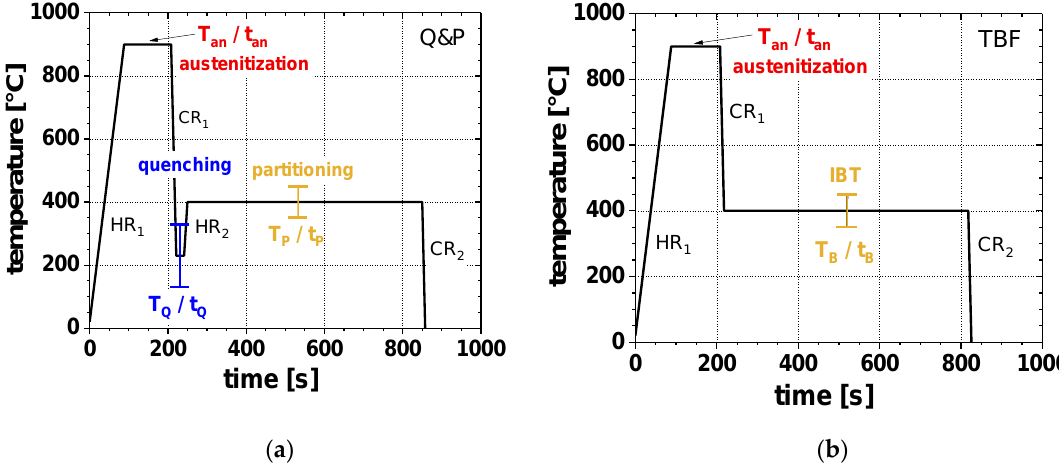
Figure 1. Time-temperature regimes used for ( a ) the quenching and partitioning (Q&P) and ( b ) the transformation induced plasticity (TRIP) aided bainitic ferrite (TBF) heat-treatments.